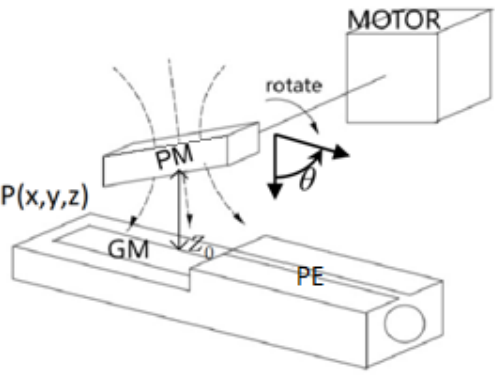
Figure 4. The structure diagram of angle sensor.